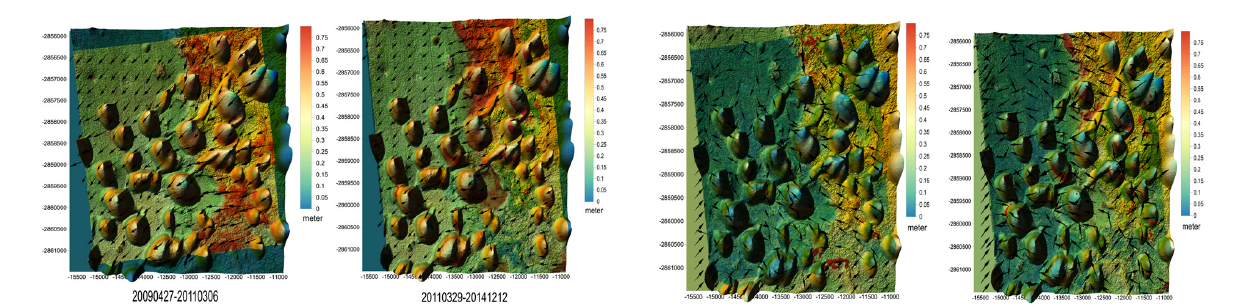
(b) After applying offset (>0.3 pixel) value estimated from jittered portions.